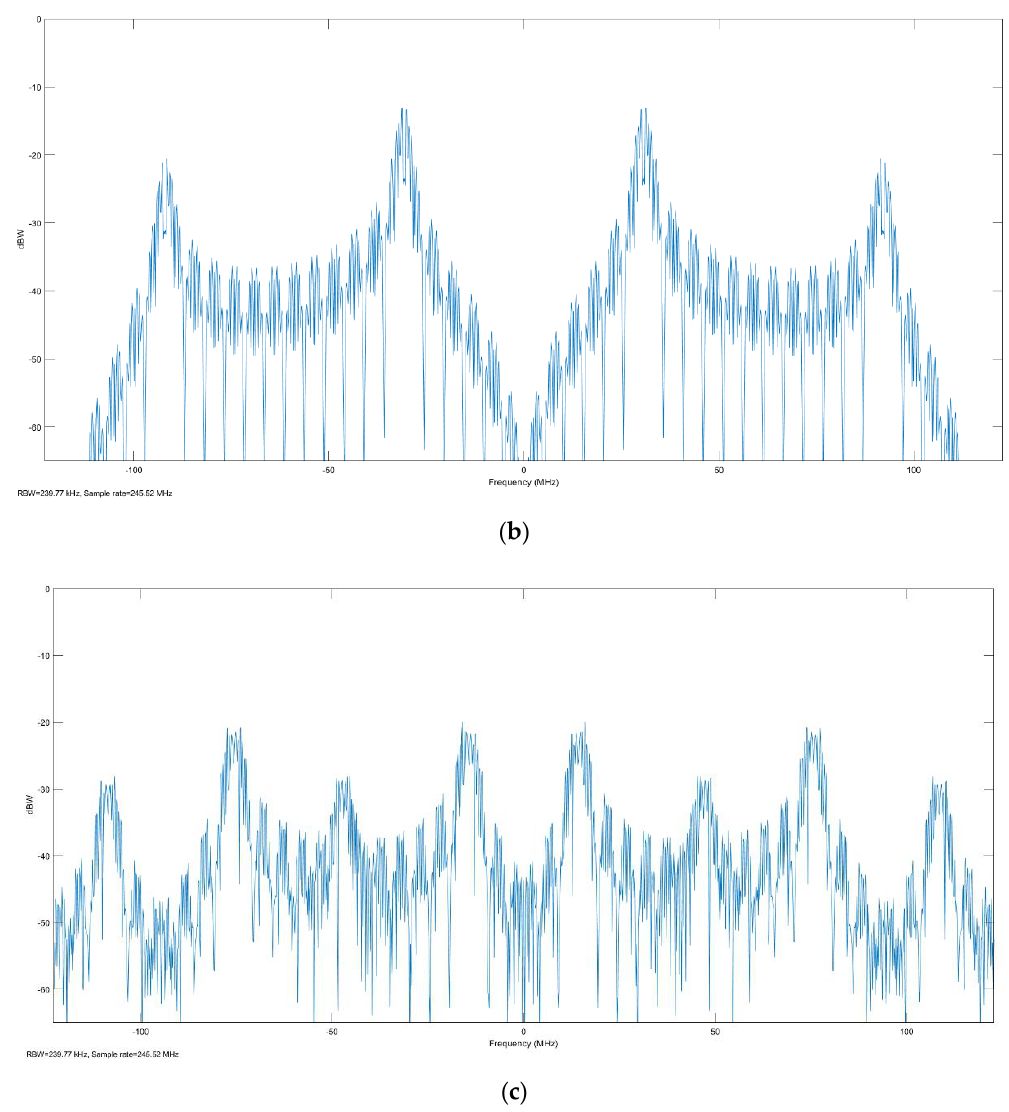
Figure 1. The characteristics of the BOCcos(30,5) and 16APSK integrated signal. ( a ) The constellation of 16APSK ( b ) The spectrum of BOCcos(30,5) at the baseband ( c ) The spectrum of BOC(30,5)cos and 16APSK at the IF.